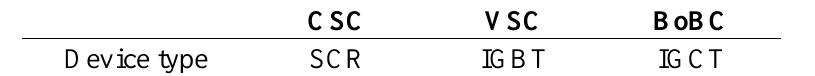
Table 1. A listing of candidate semiconductors for converter realization for the three topologies.